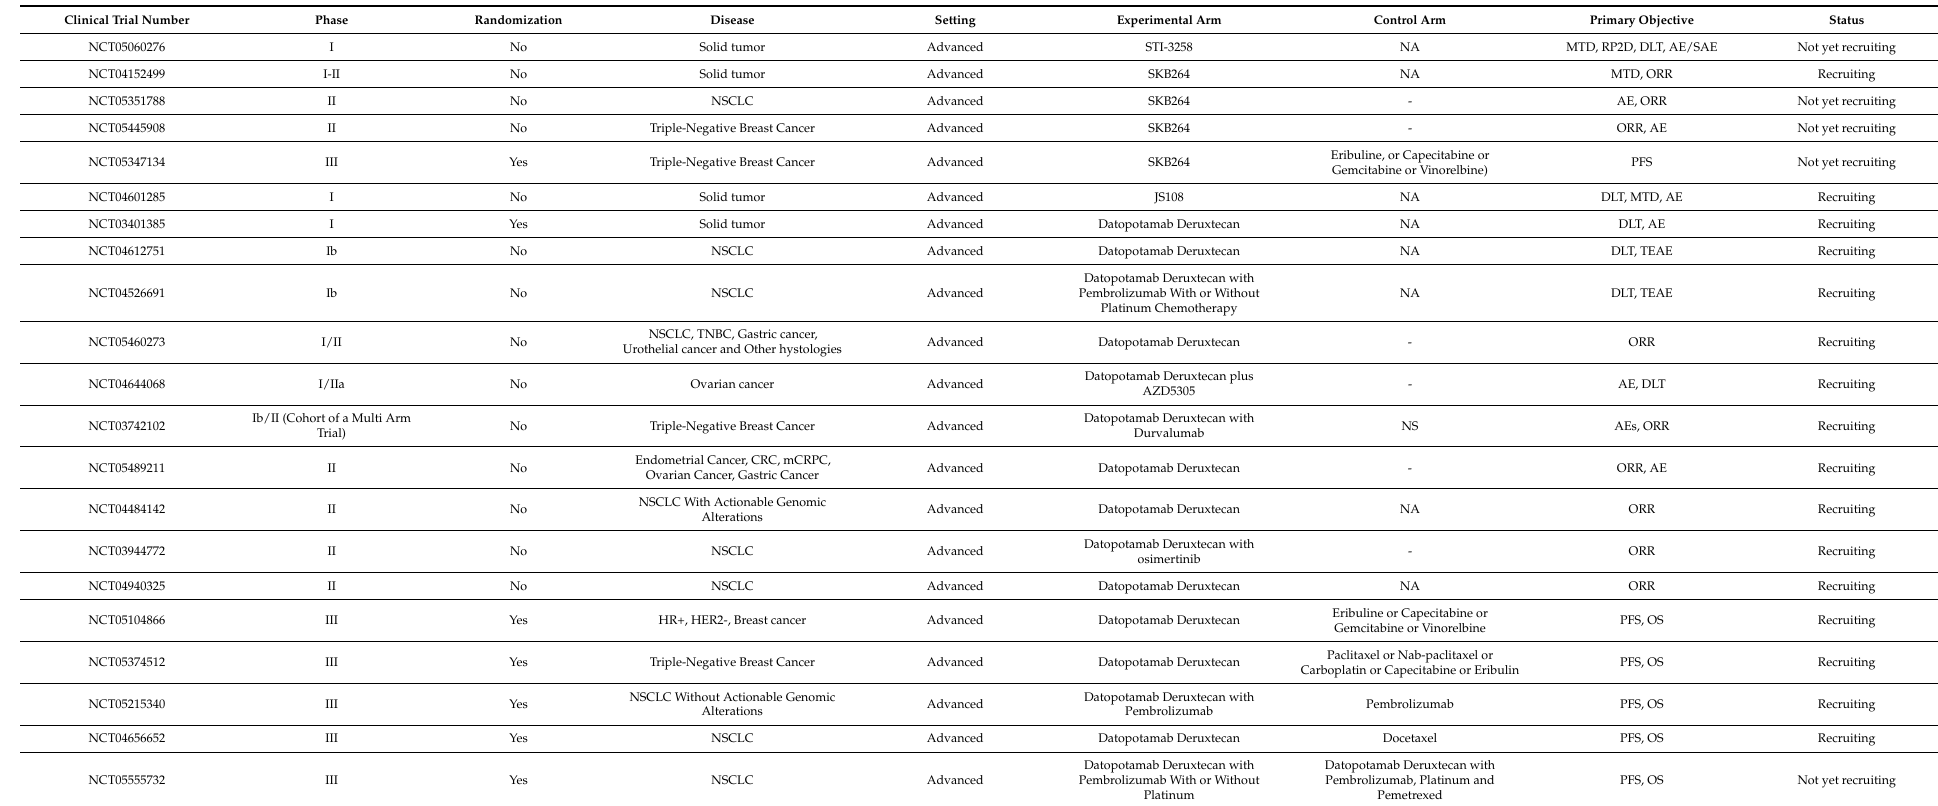
Table 3. Ongoing clinical trials with anti-TROP2 drugs other than Sacituzumab Govitecan.